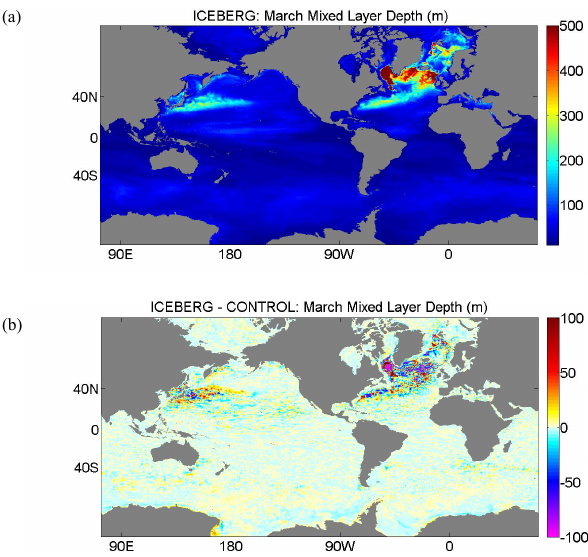
Figure 11. Mixed layer depth in March (year 26–30 average): (a) ICEBERG; (b) ICEBERG minus